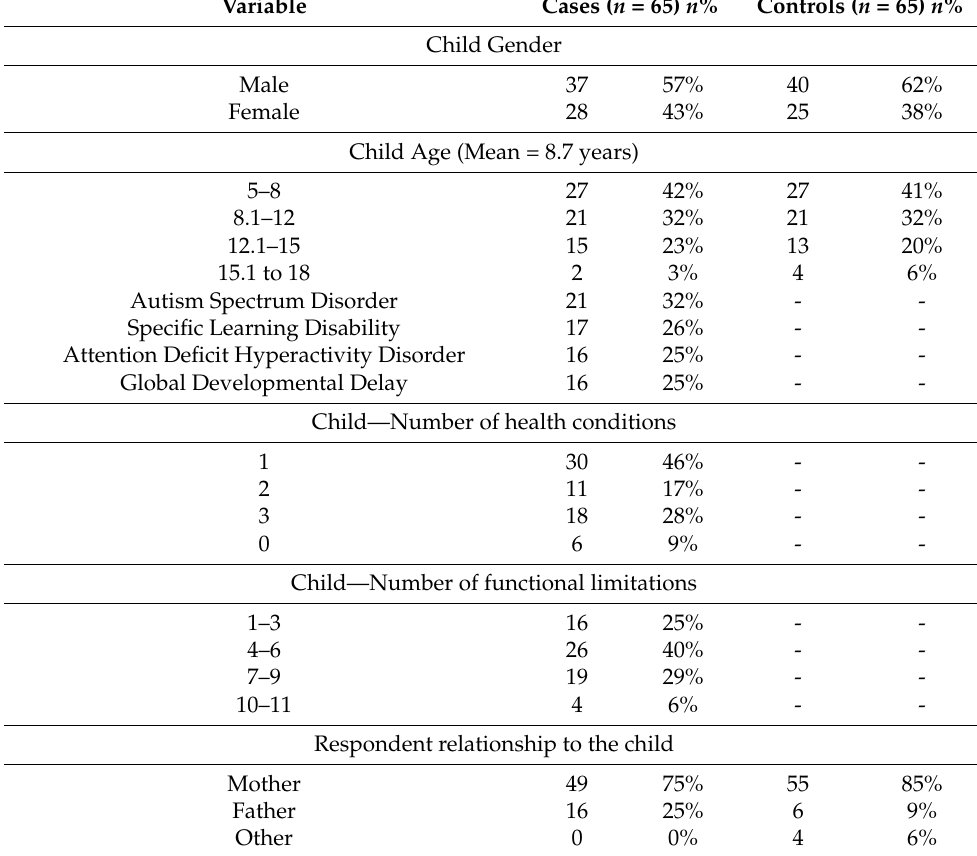
Table 3. Sociodemographic details of caregivers and